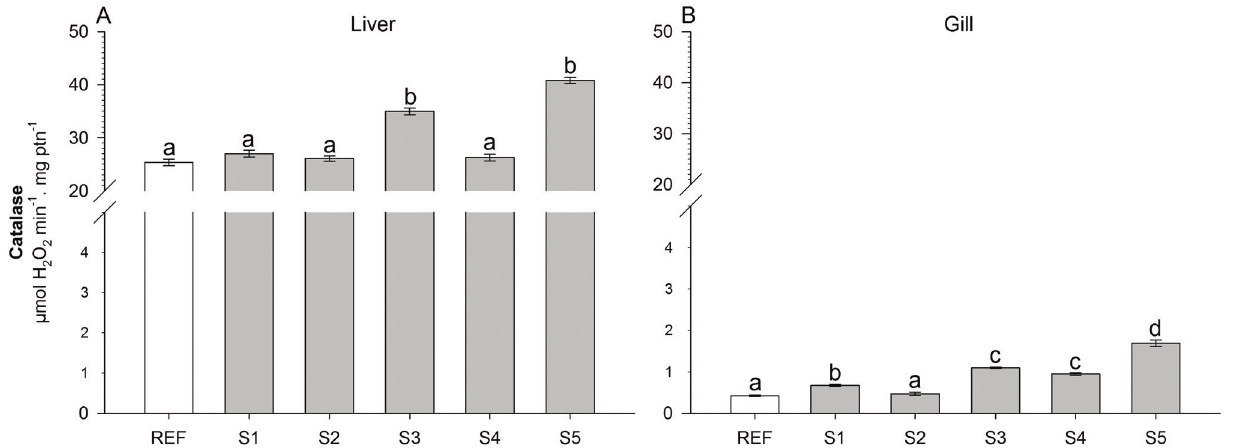
Fig. 3. Activity (mean ± SEM, n = 8) of catalase in liver (A) and gills (B) of A. altiparanae exposed in situ for seven days in five sites along Água das Araras stream (S1, S2, S3, S4, and S5) and in a reference site (Ref). Different letters indicate significant differences between sites (P < 0.05).